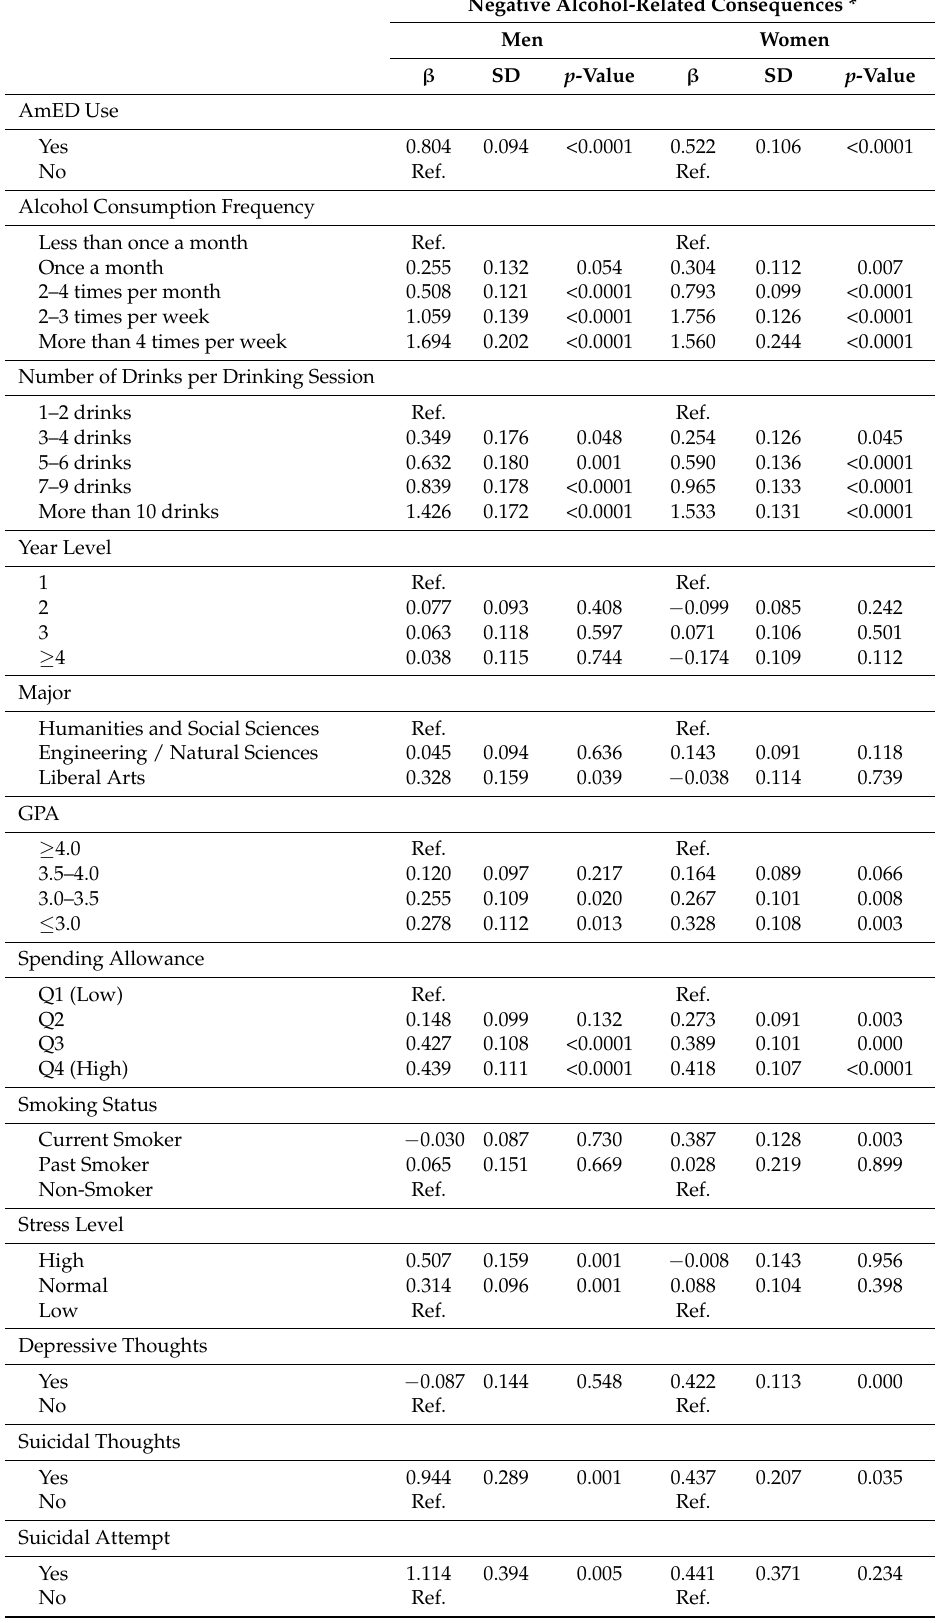
Table 2. Results of the linear regression analysis analyzing the effect of alcohol mixed with energy drinks (AmED) use on negative alcohol-related